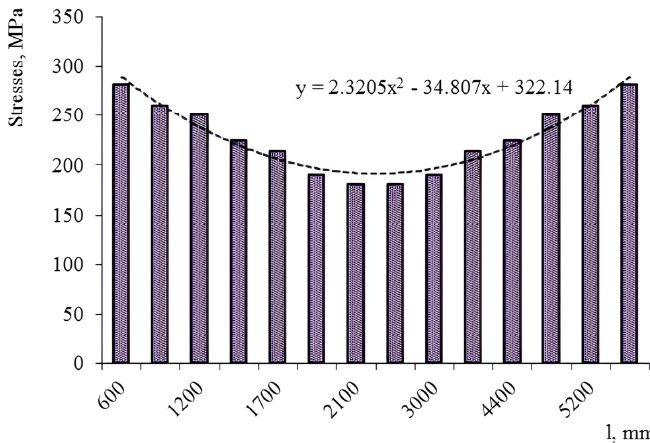
Figure 14. Stress–strain state of the removable module.